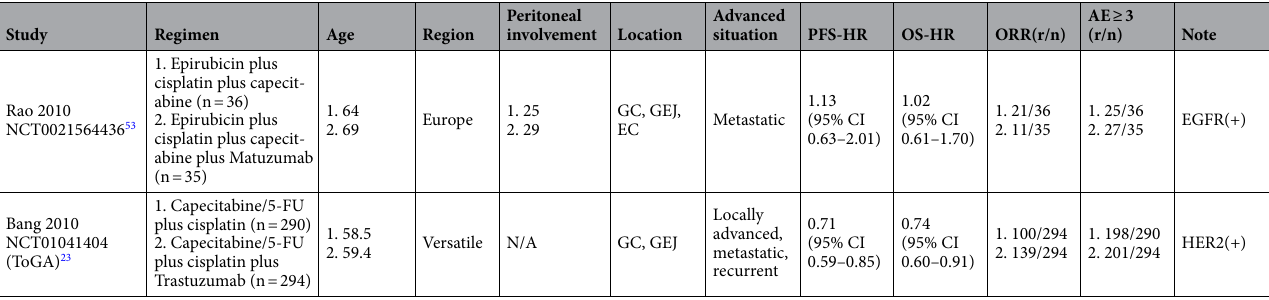
Table 2. Baseline characteristics of eligible studies in specific positivity group. GC gastric cancer, GEJ gastroesophageal junction cancer, EC esophageal